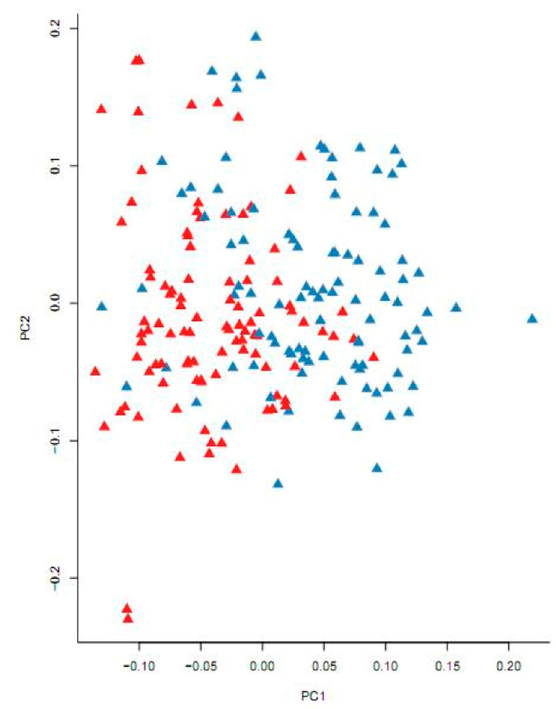
Figure 3. Principal component analysis performed with the GCTA package. Blue triangles represent NWMs and red triangles represent DWMs. Samples with the same body shape tend to come together, which implies that population stratification should be considered in the subsequent genome-wide association studies (GWAS). PC1: Principle component 1; PC2: Principle component 2.